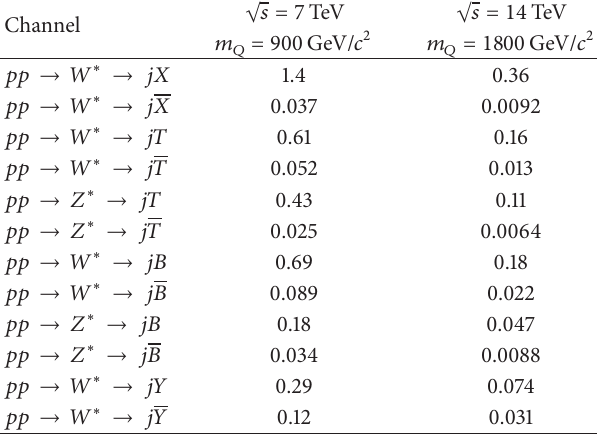
Table 2: Electroweak single production cross-sections (in pb) as a function of the mass 𝑚 𝑄 of the heavy quark, assuming order unity couplings as computed in [12]. In contrast, strong pair production = 900 and 1800 GeV/ 𝑐 2 at 𝑝𝑝 → 𝑄𝑄 yields 3.61 ( 0.63 )fb for 𝑚 𝑄 √𝑠 = 7 and 14TeV.